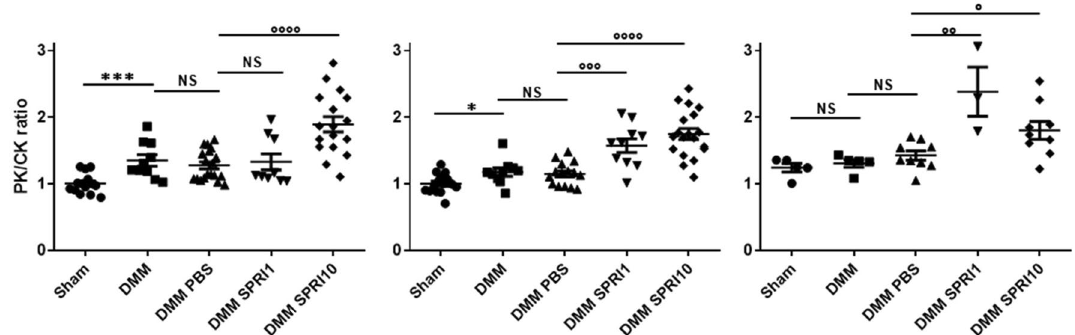
Figure 3. Time course of 99m Tc-NTP 15-5 ratios (PK/CK ratio = uptake of pathological knee/uptake of contralateral knee) in Shams, DMM, DMM + PBS, DMM + 3 × 1 µg sprifermin (DMM SPRI1) and DMM + 3 × 10 µg sprifermin (DMM SPRI10) at W7 (left), W12 (middle) and W24 (right) post-surgery. Results are mean ± SEM. DMM versus Sham: *p < 0.05, ***p < 0.001; DMM sprifermin versus DMM PBS: °p < 0.05, °°p < 0.01, °°°p < 0.001, °°°°p < 0.0001; NS: